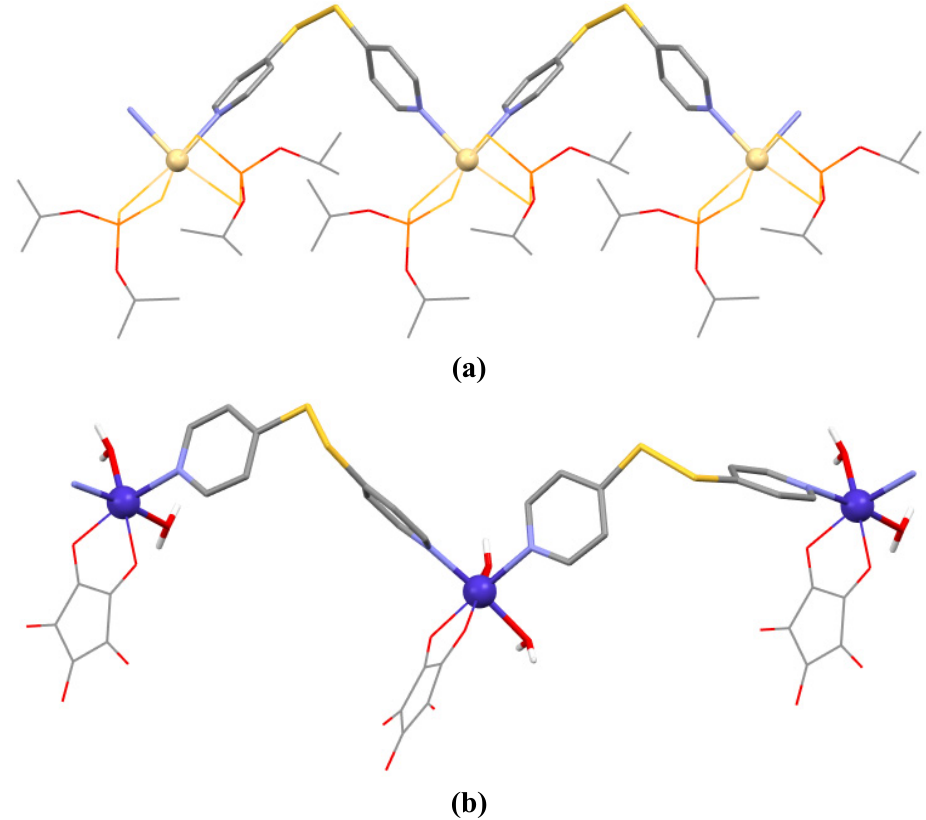
Figure 10. ( a ) Arched chain in [Cd(C right-handed P form of dtdp and the right-handed ∆ configuration of the cis -octahedral metal units; ( b ) Arched chain in [Co(H the P form of the crystallographically distinct dtdp ligands and the left-handed Λ configuration of the metal